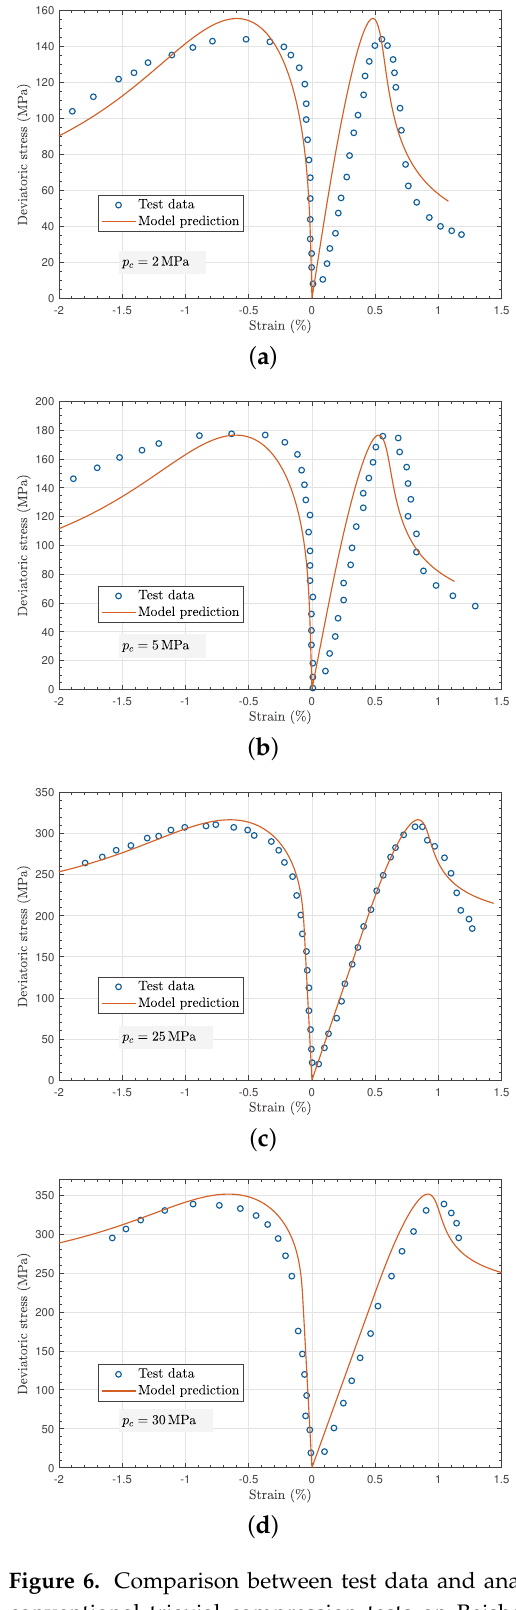
Figure 6. Comparison between test data and analytical simulation of stress–strain curves from conventional triaxial compression tests on Beishan granite under classical confining